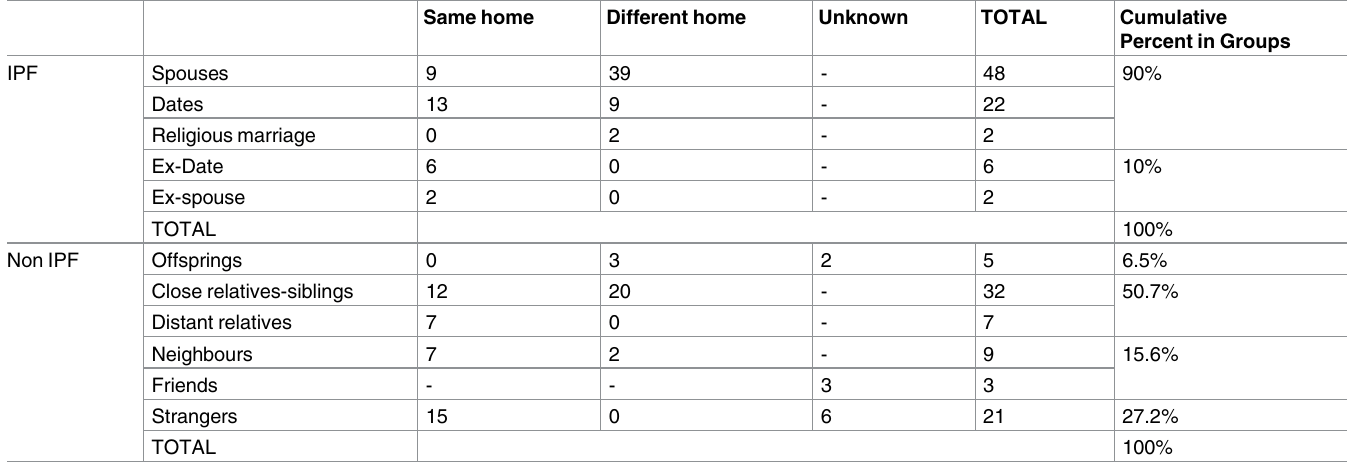
Table 3. Ratio of living together with victim among